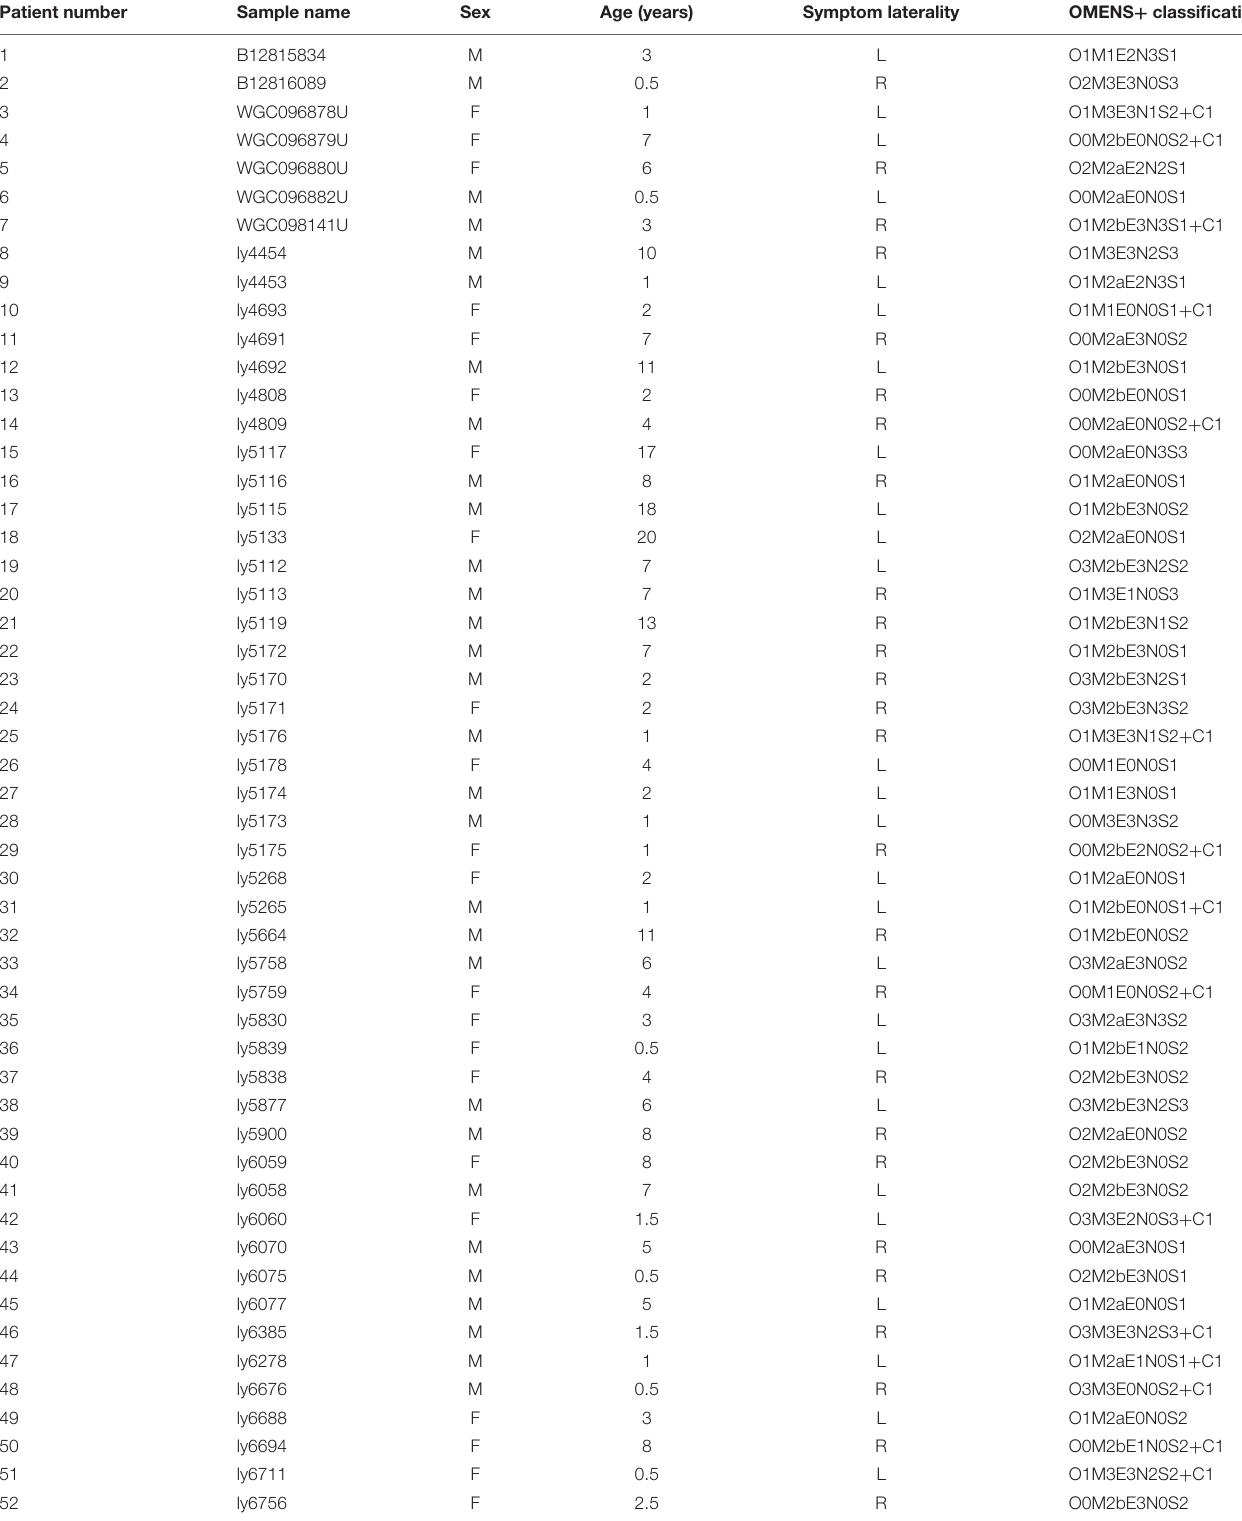
TABLE 1 | Clinical information for the 52 analyzed patients with hemifacial microsomia. Patient